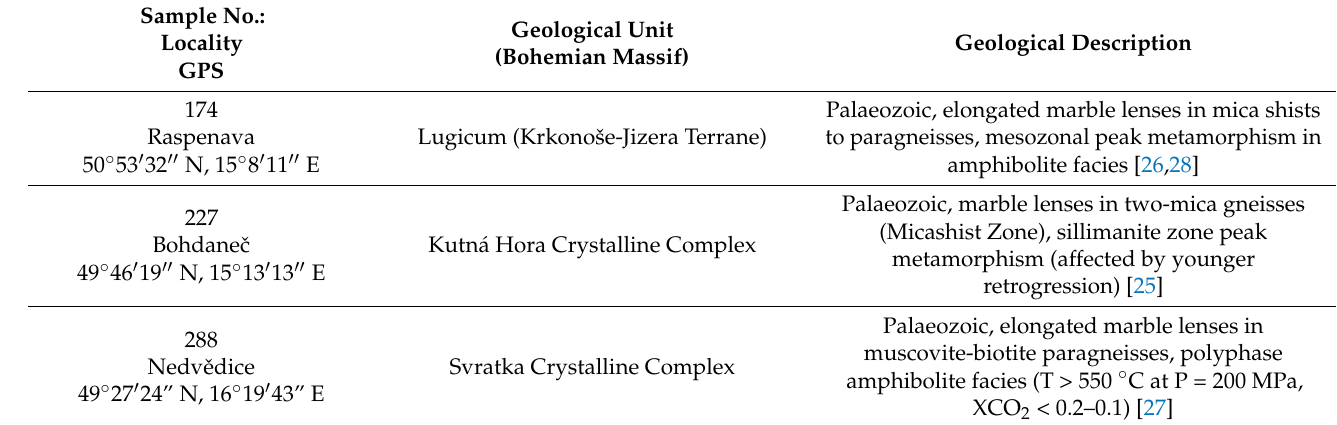
Table 1. Locations and geological descriptions of studied samples. Data modified after [23]. Abbrevi-